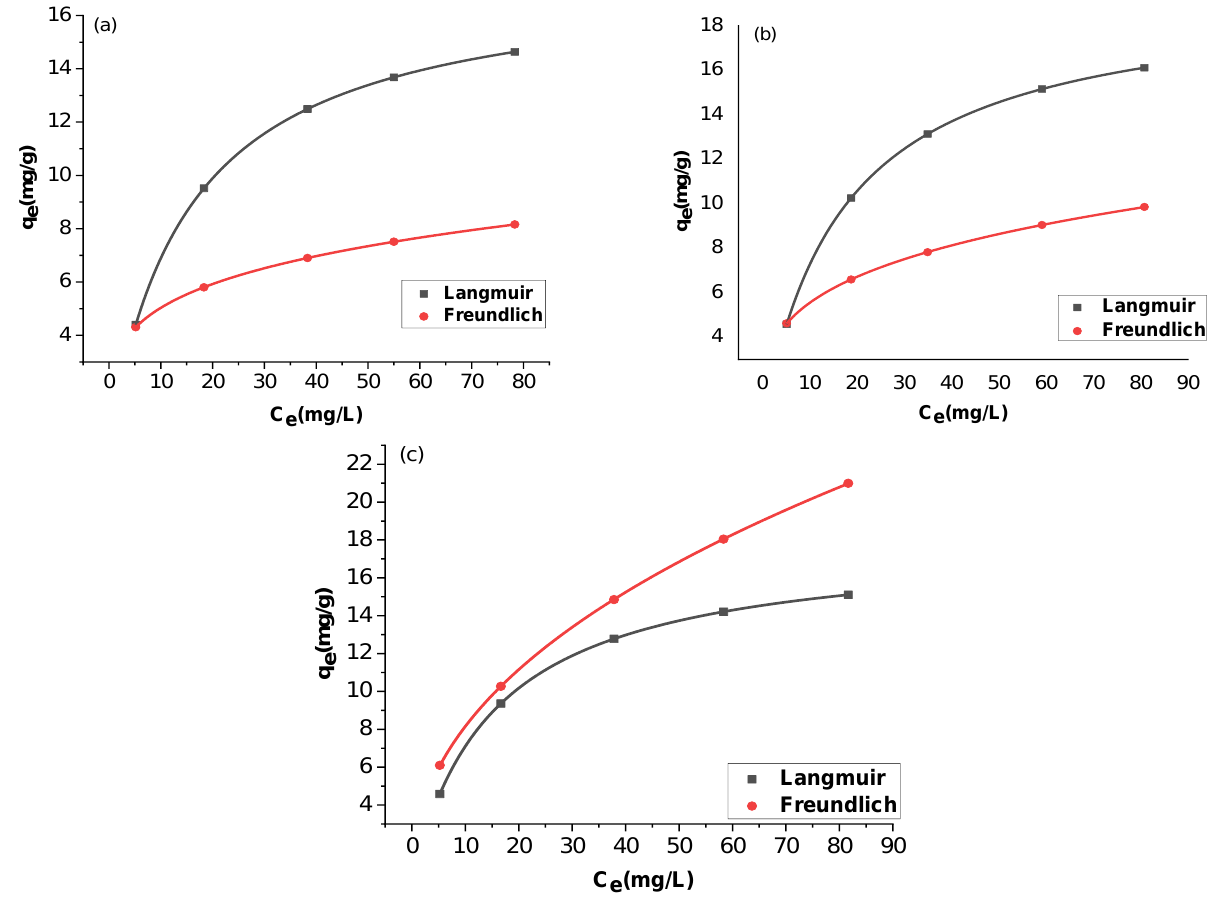
Figure 12. Nonlinear fitting of GO at 298 K ( a ), 303 K ( b ), and 308 K ( c ). Table 1. Non-linear fitting of models for Cr (VI) adsorption.